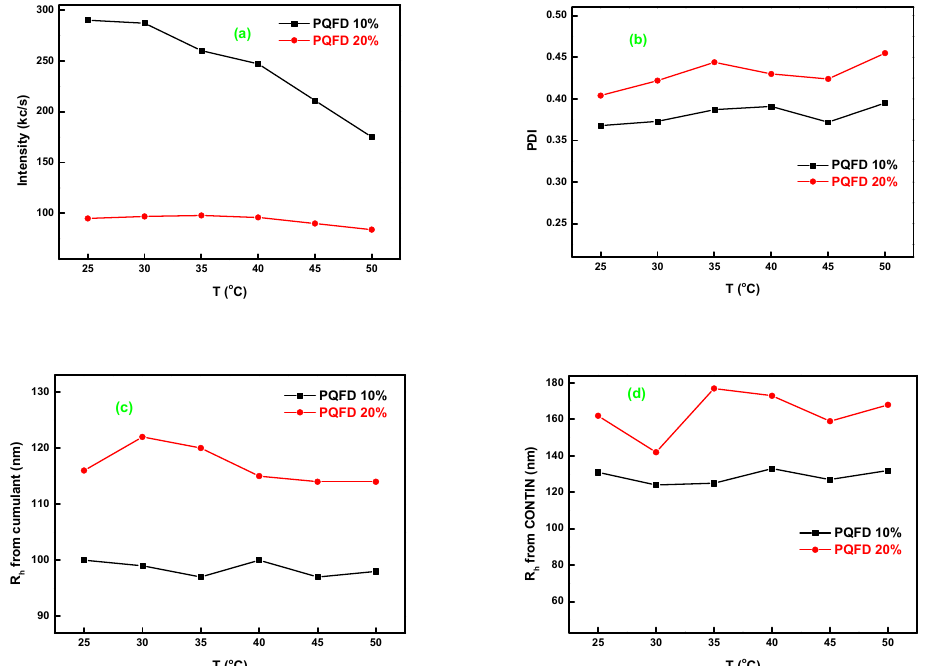
Figure 5. Dependence of ( a ) scattering intensity, ( b ) PDI, ( c ) R h (from cumulants method), and ( d ) R h (from CONTIN) of the PQFD 10% and PQFD 20% copolymer solutions (H 2 O protocol) on temperature changes .